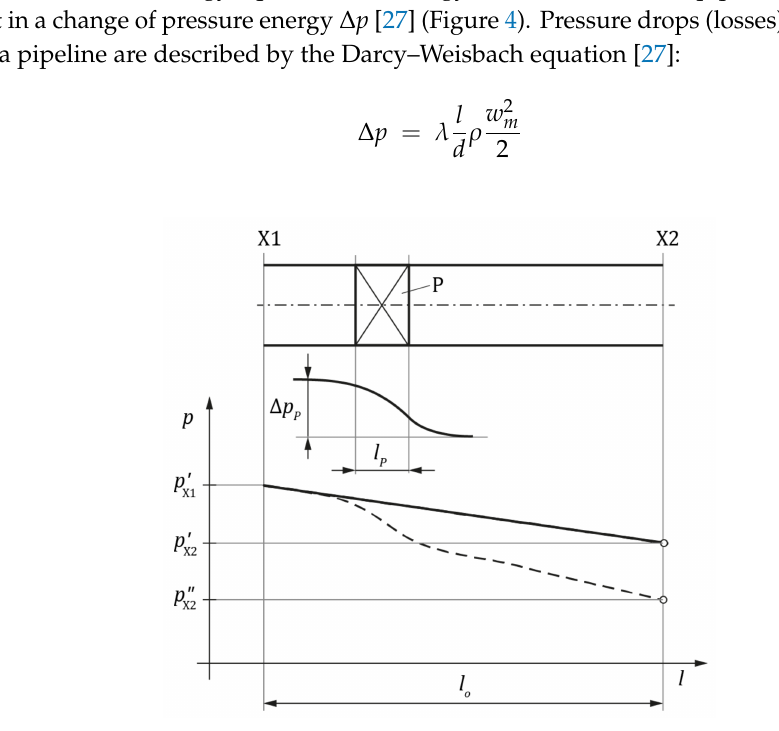
− p (cid:48) ) is the loss at the straight X 1 X 2 − p (cid:48)(cid:48) ) is the total loss at the section l o X 1 X 2